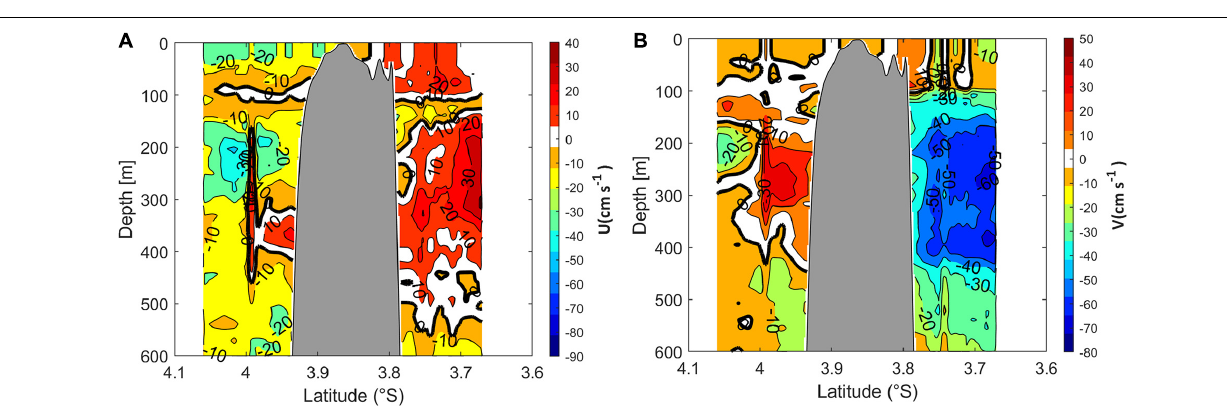
a maximum intensity of 40 cm s − 1 at ∼ 4.5 ◦ S ( Figure 11C ). In the subsurface layer (100–400 m) SEUC intensity was maximal of 40 cm s − 1 in the east side of FN at ∼ 200 m depth ( Figure 11D ). These changes in the intensity and direction of the currents around the islands can be related to local